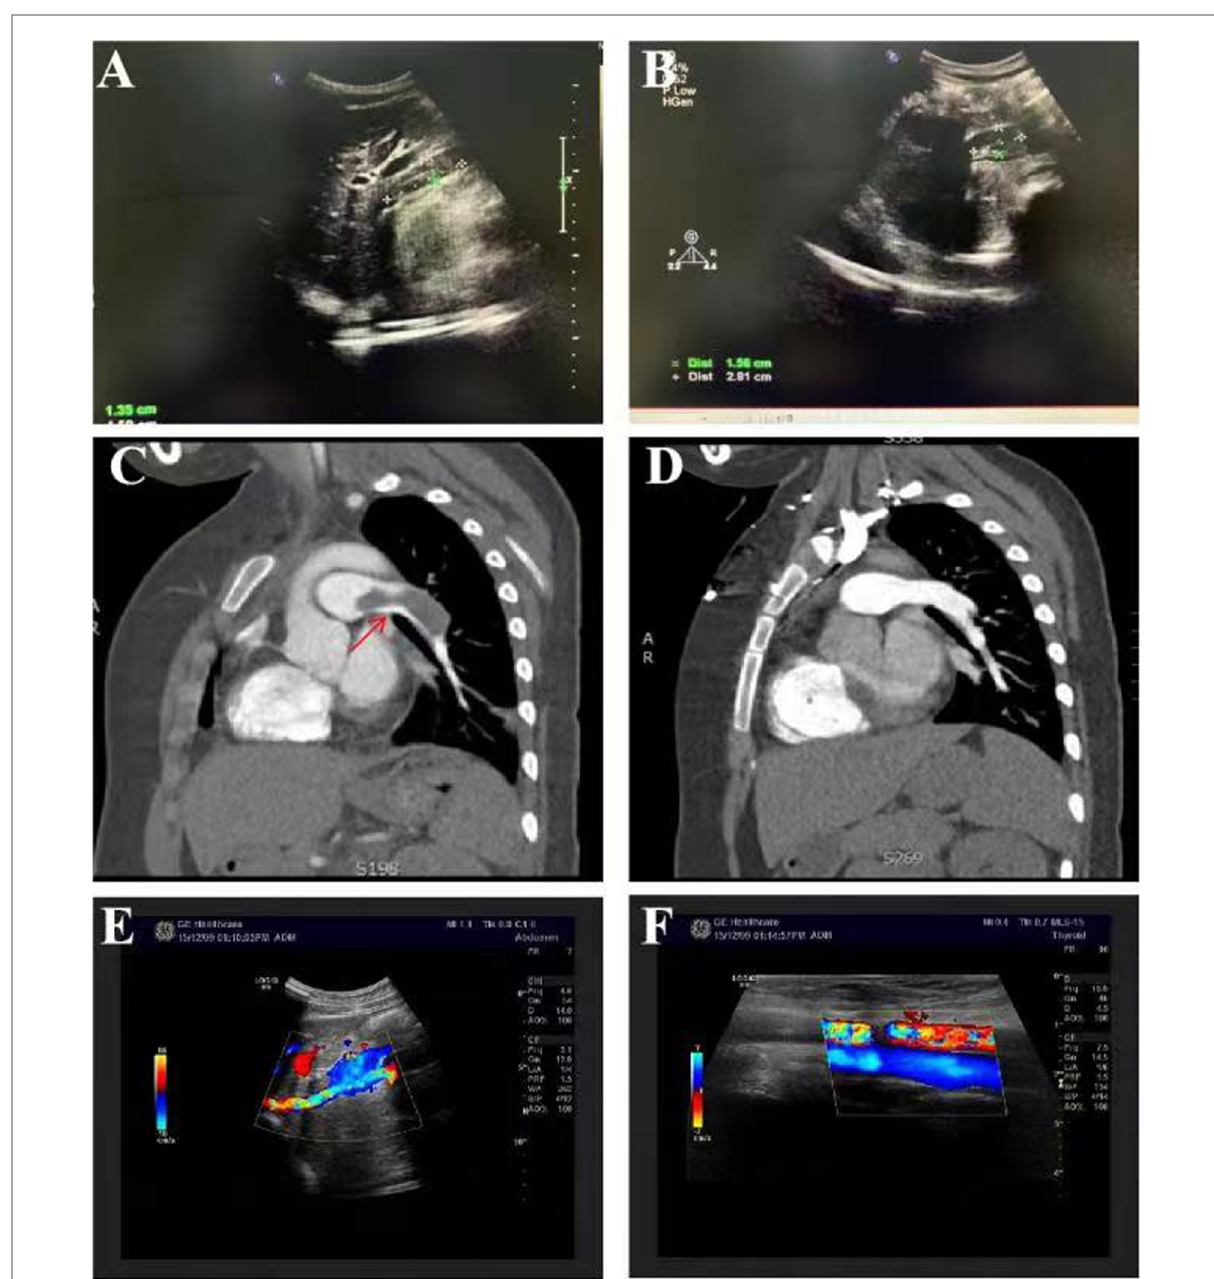
FIGURE 2 Clinical features of the current patient. Among auxiliary examinations, color Doppler ultrasound showed hypoechoic masses in the wall of the inferior vena cava ( A ), and of the right renal vein ( B ), considering the possibility of thrombosis. Pulmonary artery CT angiography (CTA) showed embolisms of the distal main pulmonary artery, left pulmonary artery trunk and its intrapulmonary branches, and the right lower pulmonary artery ( C ), considering the possibility of ischemic infarction. The thrombi disappeared after effective treatment ( D ). Vascular B-ultrasound showed bilateral popliteal vein blood fl ow, and bilateral mural thrombosis was considered ( E-F